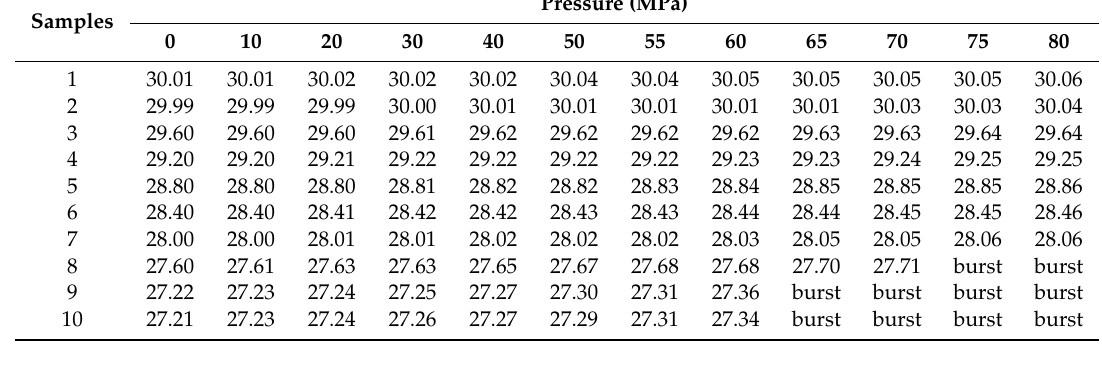
Table 3. The measured values of exterior diameter.